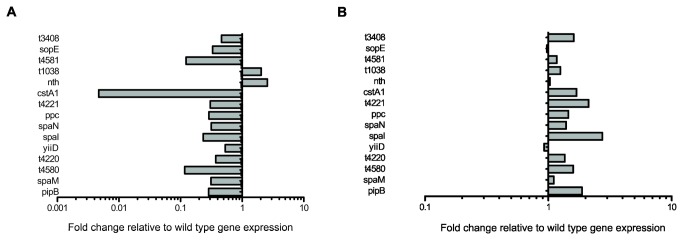
qRT-PCR analyses of differentially expressed genes of the S.
Typhi ΔyehUT mutant. A The relative expression levels of the 15 genes found to be differentially expressed on microarray analysis of the S. Typhi ΔyehUT mutant when compared to S. Typhi in low salt LB, at mid-log phase, at 37°C (Table S6 in File S1). The 15 genes examined are listed on the y-axis. Grey boxes < 1.0 indicates down regulated genes and grey boxes >1.0 indicates up regulated genes relative to S. Typhi. B qRT-PCR analysis showing relative expression levels of genes after complementation of the ΔyehUT mutant compared to S. Typhi (Table S6 in File S1).